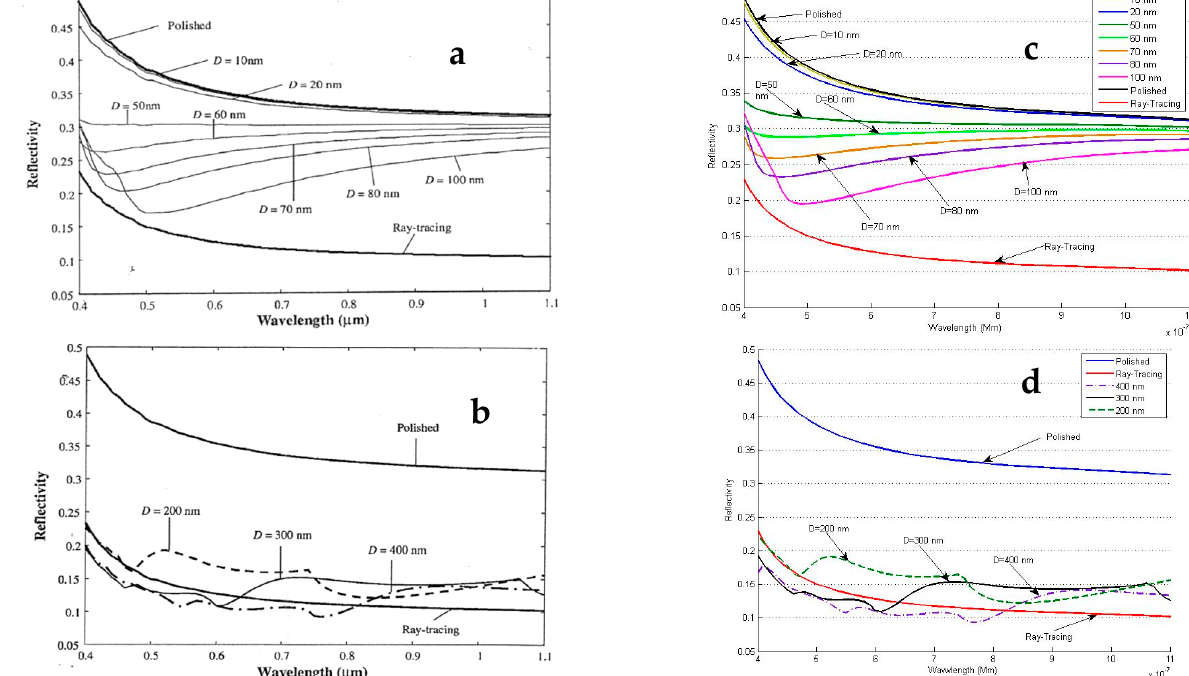
Figure 2. Spectral reflectance of a triangular simulation with ( a ) several different periodicities and ( b ) three different periodicities taken from reference [18], ( c ) and ( d ) the outputs of our code for the examples given in ( a ) and ( b ), respectively.